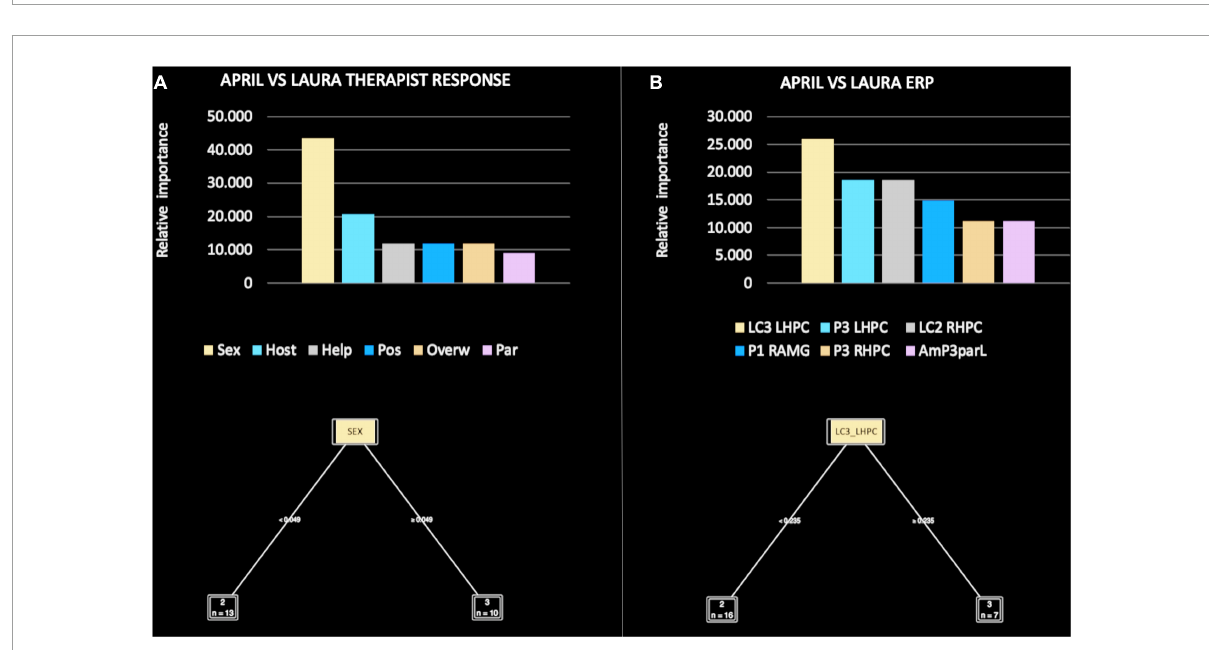
FIGURE7 Relative importance of all therapist response patterns (A) and event-related potential (ERP) components (B) , included in the machine learning (ML) model for April versus Laura.